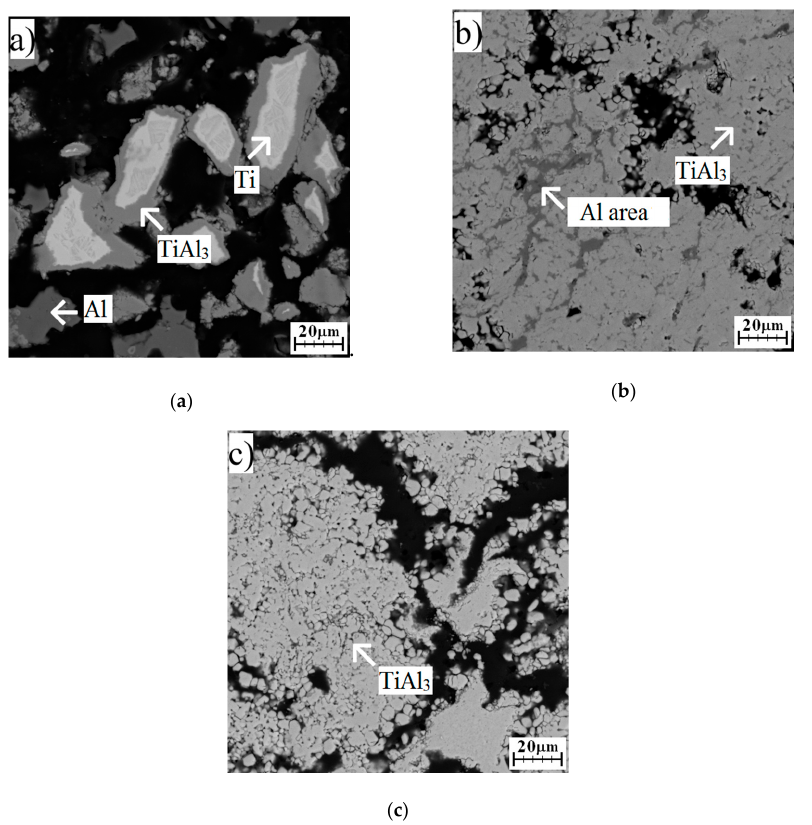
Figure 8. The microstructure of TiAl63 alloys annealed at 600 °C for ( a ) 8 h, ( b ) 24 h, and ( c ) 48 h.